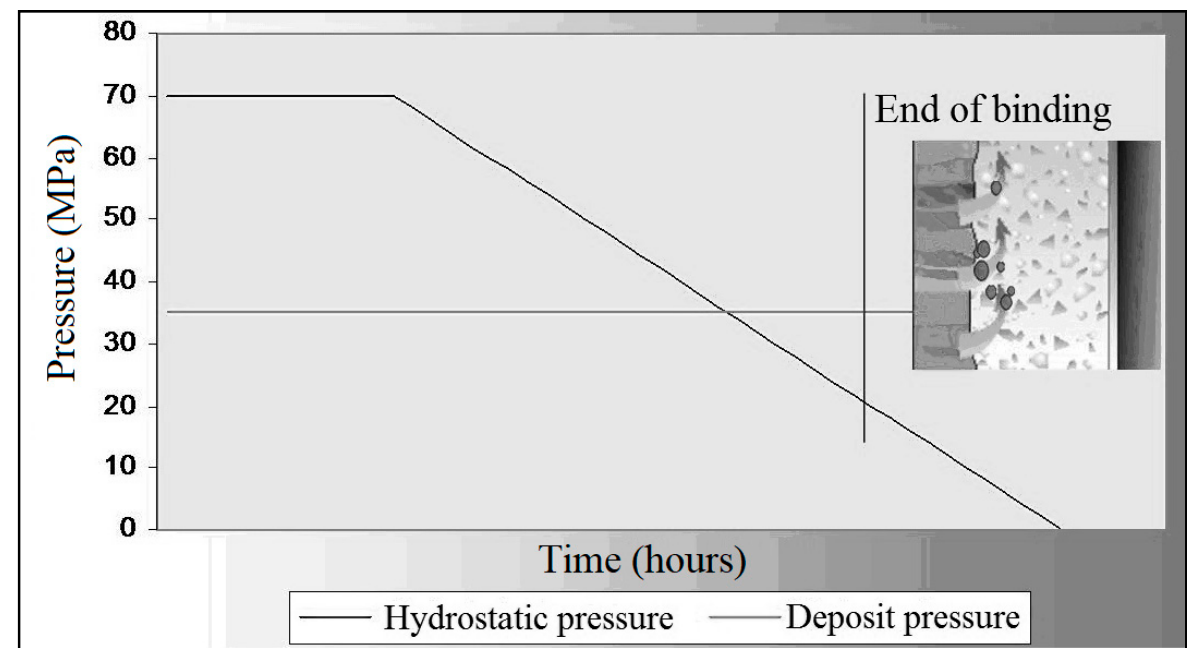
Figure 3. Diagram of hydrostatic pressure reduction below formation pressure.